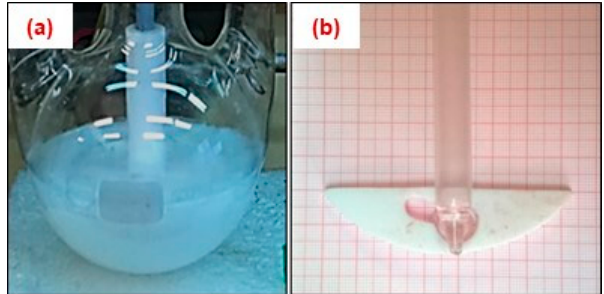
Figure 4 . ( a ) Experimental setup for the synthesis of PUA aerogel powders with disruption of gelation (vigorous agitation, 250–300 rpm; suspension and emulsion polymerization, 400 rpm). ( b ) The half-moon shaped blade used for agitation.